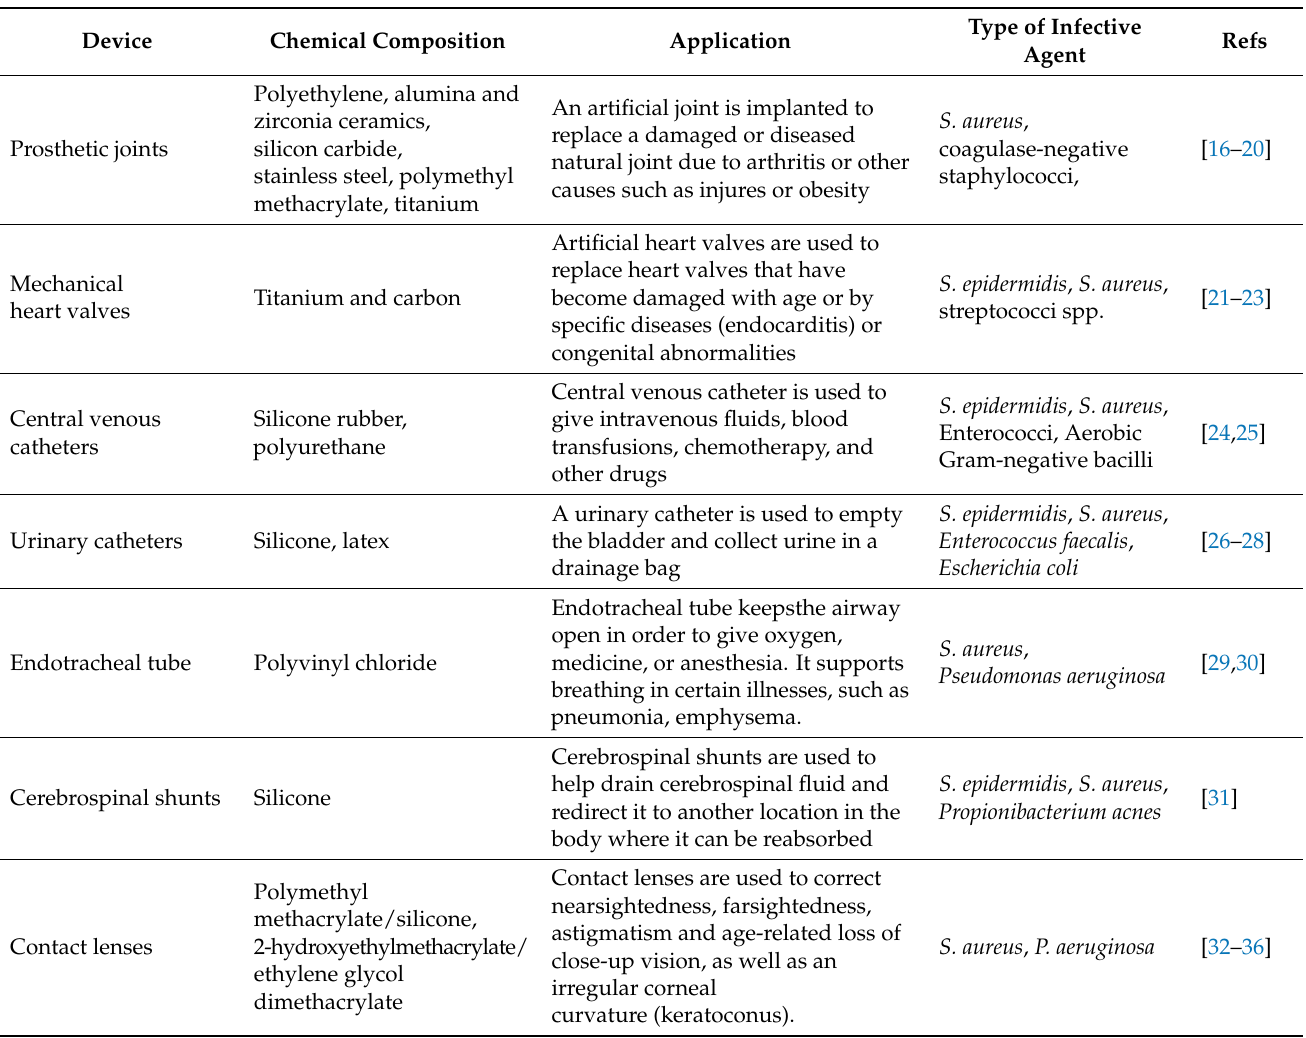
Table 1. Most used devices in human